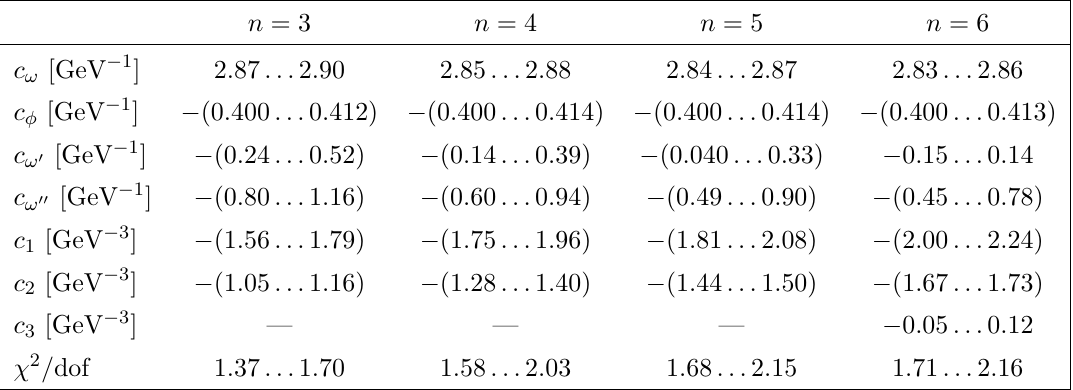
Table 1. Fit parameters and reduced (cid:31) 2 for the e + e (cid:0) di(cid:11)erent versions of the conformal polynomial with asymptotic behavior q (cid:0) (2 n +1) . The ranges indicate the variation found for the di(cid:11)erent (cid:25)(cid:25) phase shifts and values of (cid:3) 3 (cid:25) .